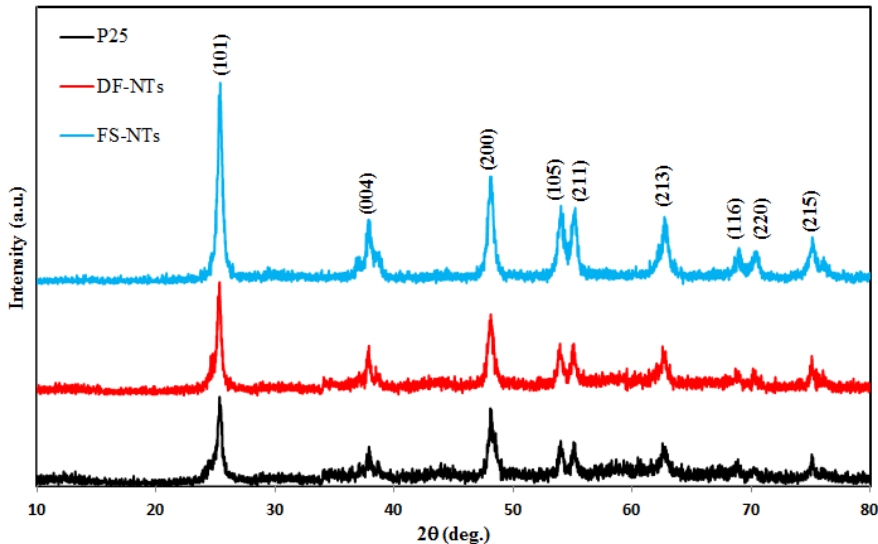
Fig. 3. XRD patterns corresponding to the annealed P25, DF-NTs and